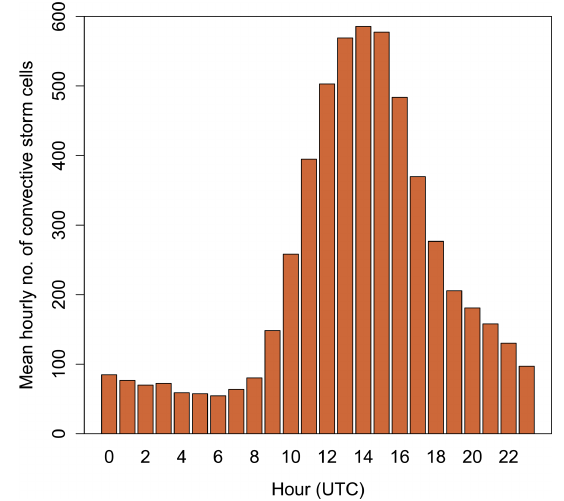
Figure 5. Hourly distribution of the mean number of convective storm cells in the Prut River basin, for the period